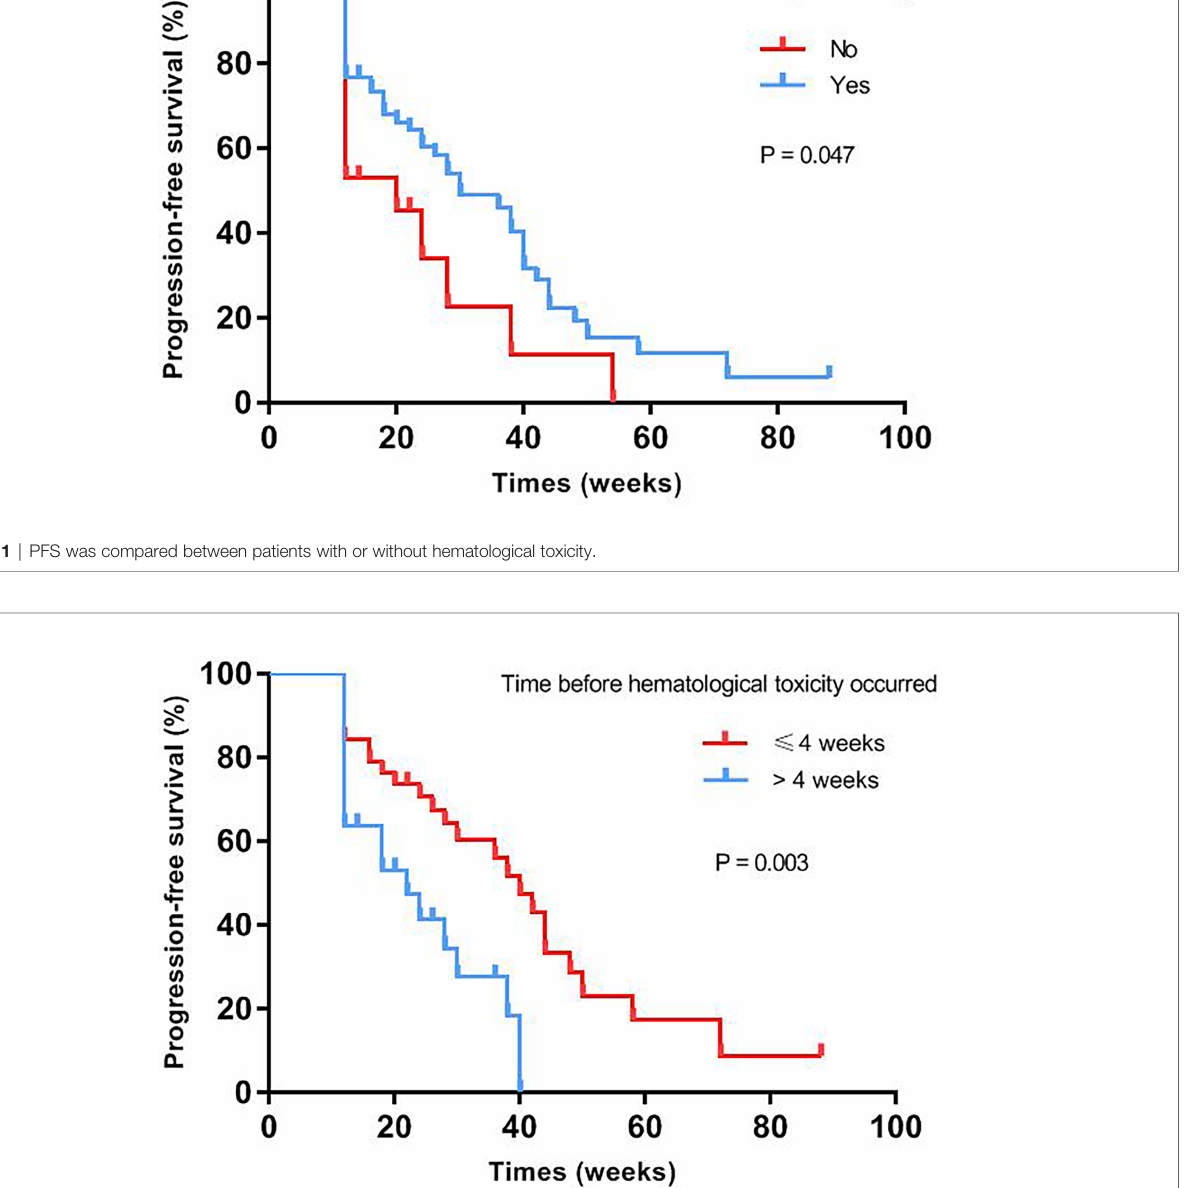
TABLE 4 | Cox regression analysis of multi-factor for predicting progression-free survival. B SE Wald df P -value HR 95% CI of HR Time of HT occurred 0.961 0.440